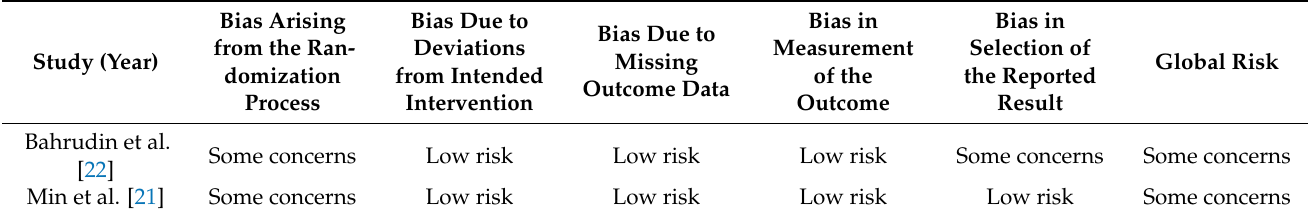
Table 3. Risk-of-bias assessment.